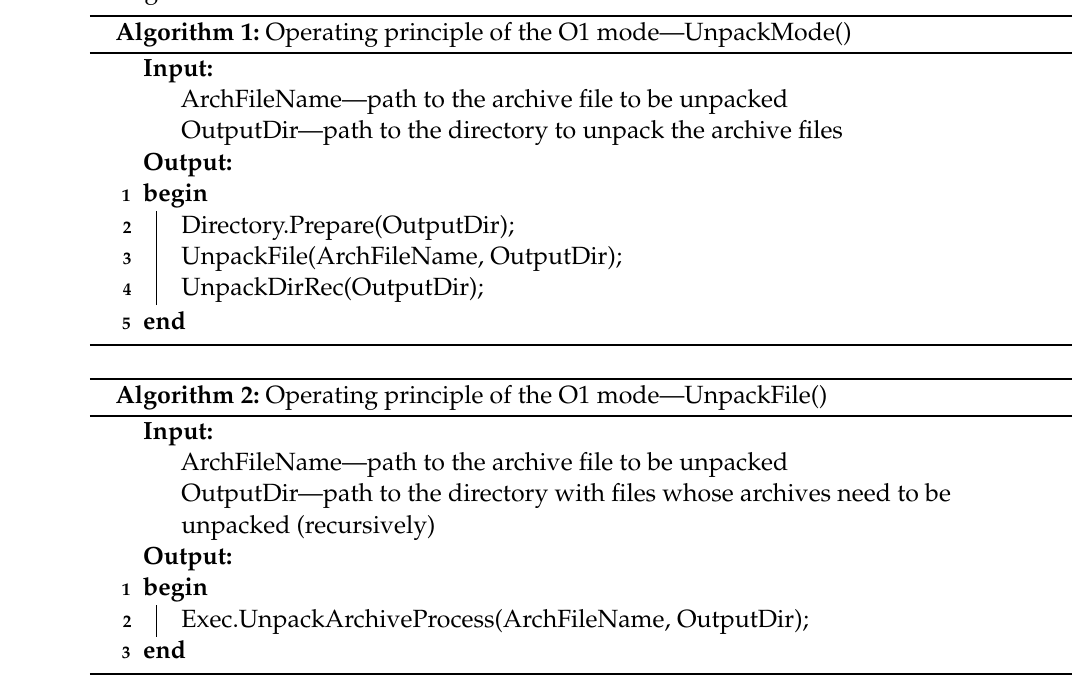
Algorithm 3: Operating principle of the O1